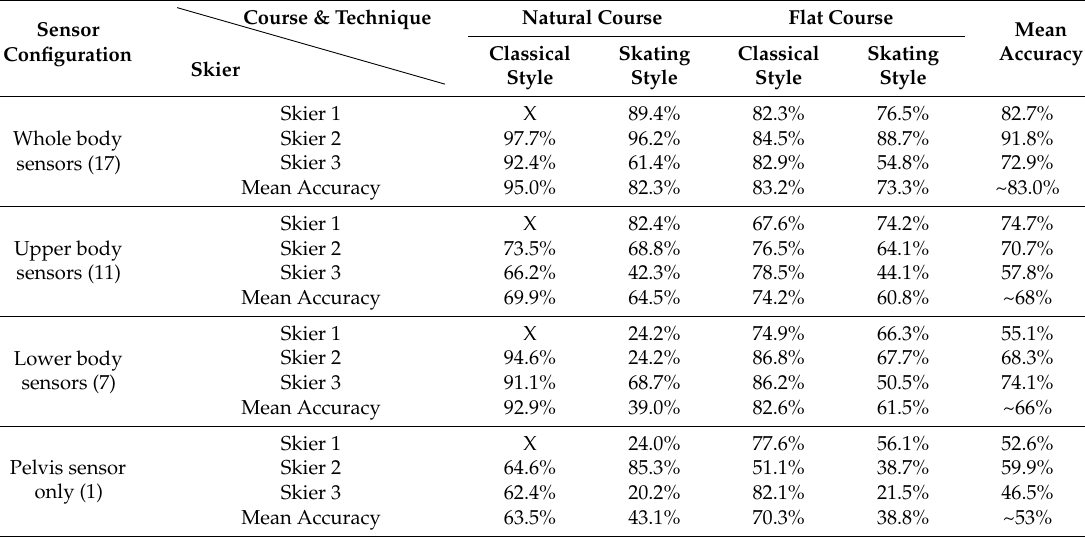
Table A8. Classification accuracies for the first three skiers using the proposed deep learning model when a leave-one-out type of testing is performed using four different sensor configurations of sensors.